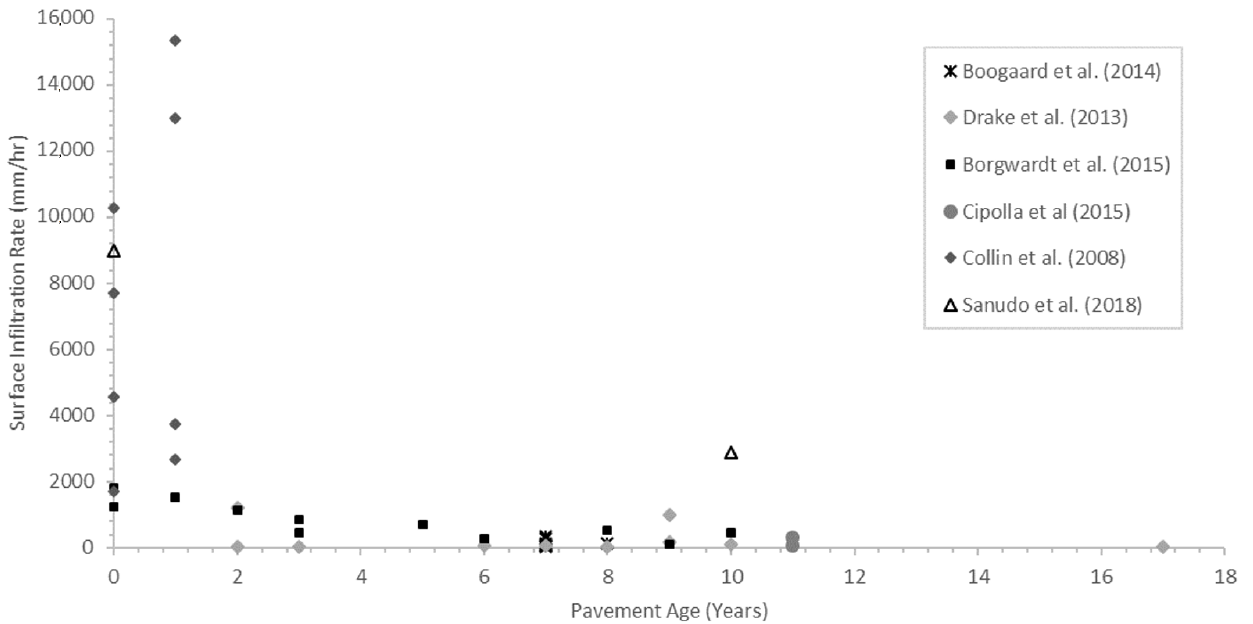
Figure 1. Surface infiltration rate versus age of PICPs (non-porous), as recorded in various past studies. (Collin et al. [6], Drake et al. [7], Boogaard et al. [10], Borgwardt et al. [11], Cipolla et al. [12], and Sañudo-Fontaneda et al. [13]).